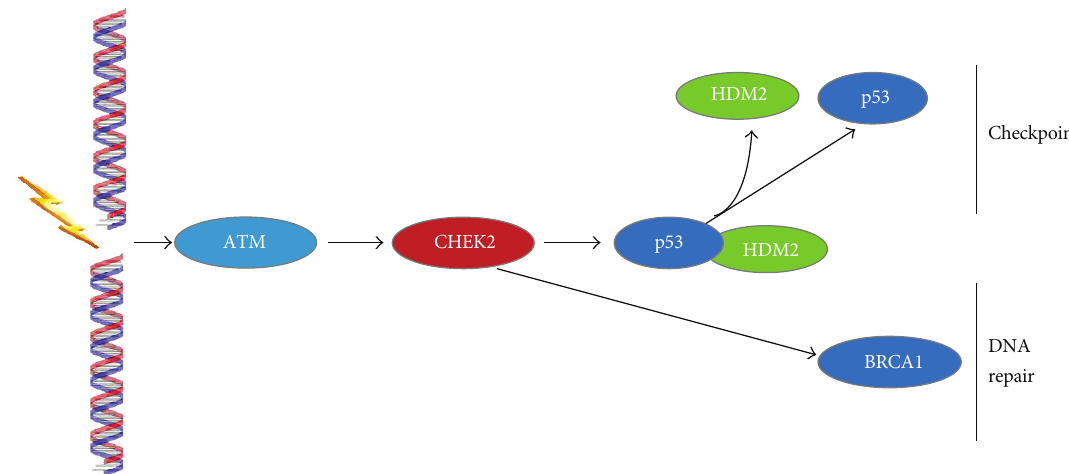
F 4: Signaling mechanism of